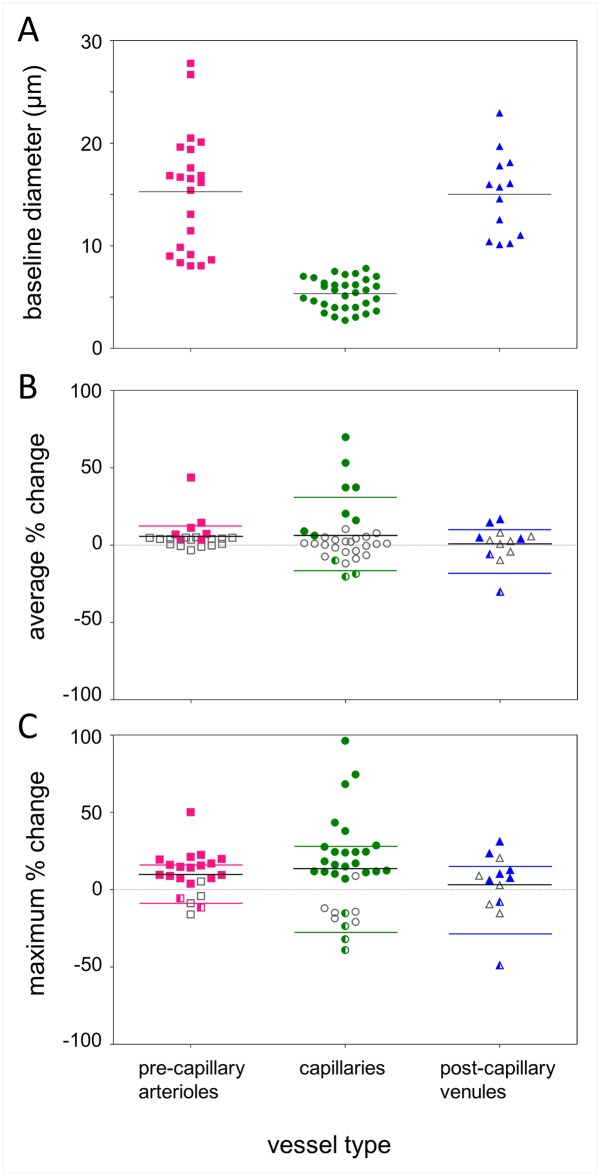
Baseline diameters and flicker-induced changes for pre-capillary arterioles, capillaries, and post-capillary venules.(A) Distribution of baseline vessel diameters (y-axis) by vessel type (x-axis) for all 67 segments included in the data set. Solid black line shows mean vessel diameter for each type of vessel. (B) Distribution of the average percentage change (y-axis) across each of the 67 segments post-flicker, grouped by vessel type. (C) Distribution of the largest regional percentage change (y-axis) seen at some point along each of the 67 segments post-flicker grouped into vessel types. For panels (B) and (C), coloured symbols show responding segments whose 2 SEM error bars did not encompass zero (see Fig 5A), i.e. segments with a definite measurable change. Filled symbols indicate a definite dilation, and half-filled symbols indicate a constriction. Unfilled grey symbols represent “non-responding” segments. These are either segments that did not show a measurable change post-flicker or whose baseline variability was greater than the change measured, which are all classified as “non-responding”. Solid black lines represent the overall average of all data points for each vessel type. Coloured lines represent the average of responses from segments with a valid response, with the average for dilations alone and constrictions alone displayed individually.